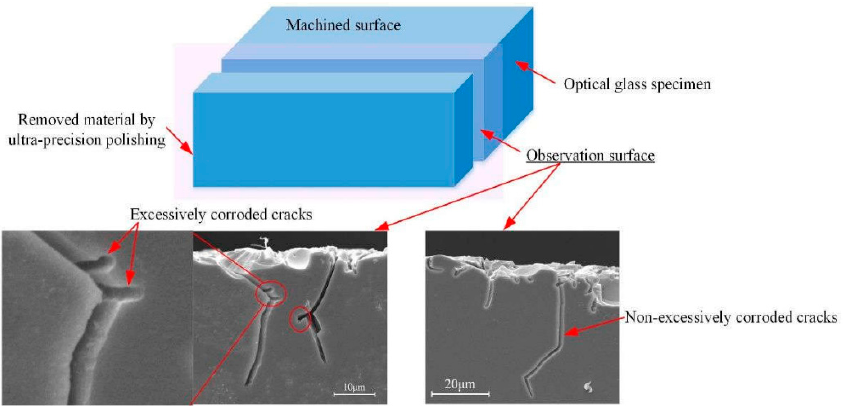
Figure 2. Subsurface cracks with different corrosion